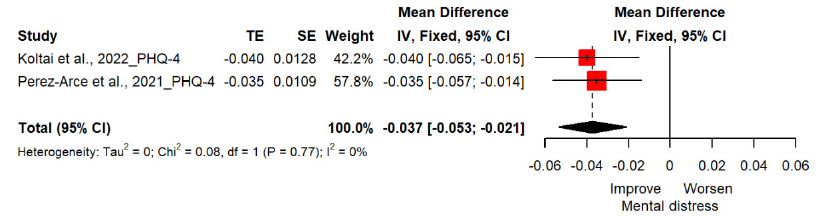
Figure 4. Forest plot diagram showing the effect of COVID-19 vaccination on distress. Mean difference; CI, confidence interval. [23,24]